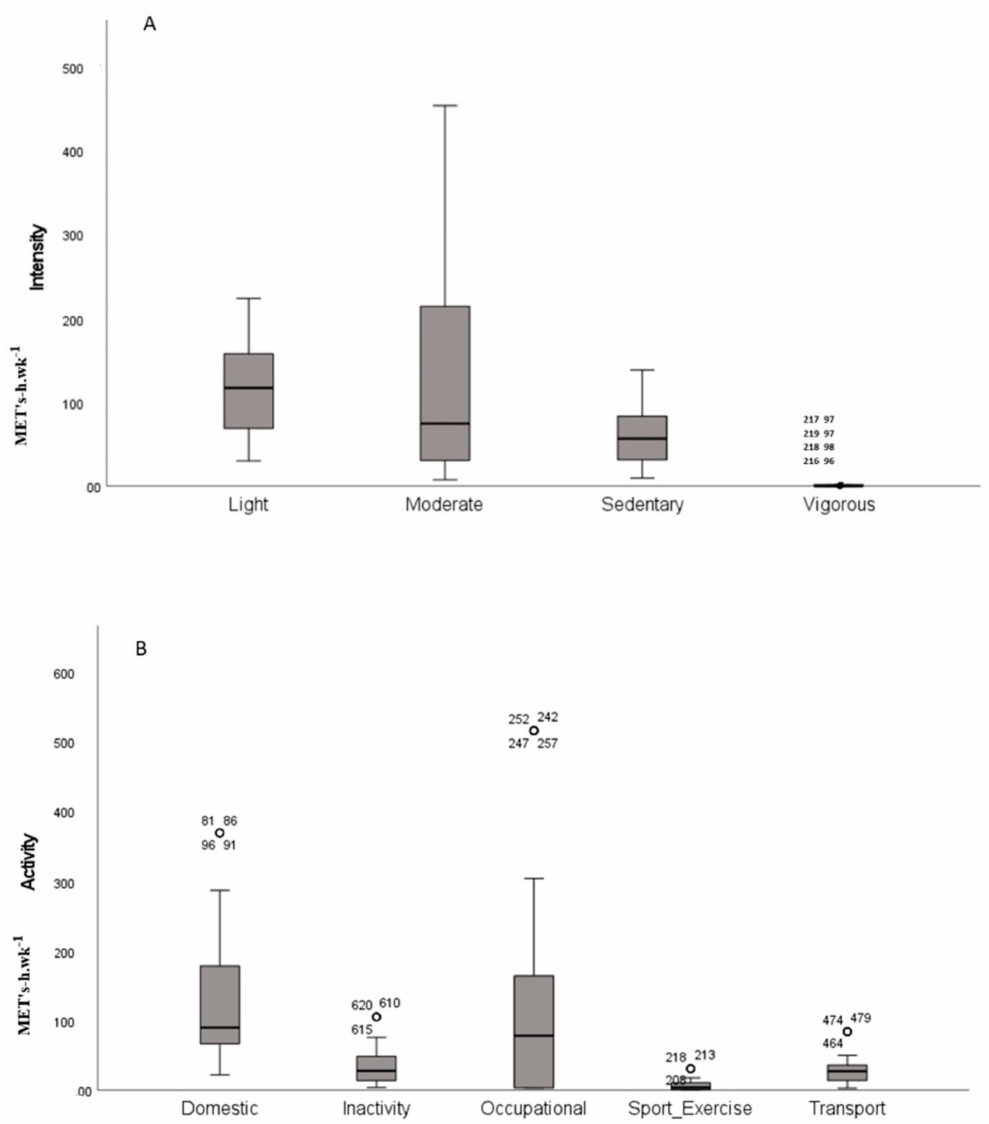
Figure 1. Dispersion results by type of intensity ( A ) and type of activity ( B ). The box plots illustrate the types of intensity (light, moderate, sedentary and vigorous) and the types of activity (domestic, inactivity, occupational, Sport/ Exercise and transport). The y -axes indicate the energy expended in METs.h · wk − 1 ; the x-axis represents ( A ) the types of intensity and ( B ) the types of